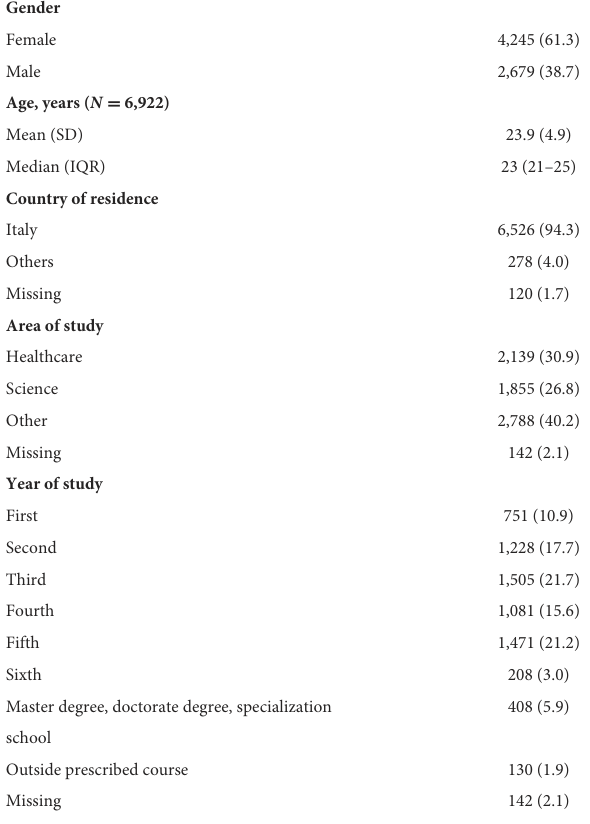
TABLE 1 Characteristics of students who were tested at least once for SARS-CoV-2 at Sapienza University of Rome from 1 March to 30 June 2021 ( N =